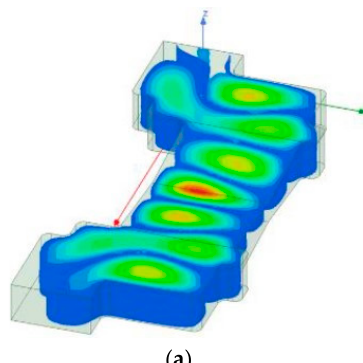
Figure 4. Simulated and measured S-parameters of the TE10-TE20-TE10 back-to-back converter. ( a ) Transmission coefficient |S 21 | and ( b ) reflection coefficient |S 11 | .